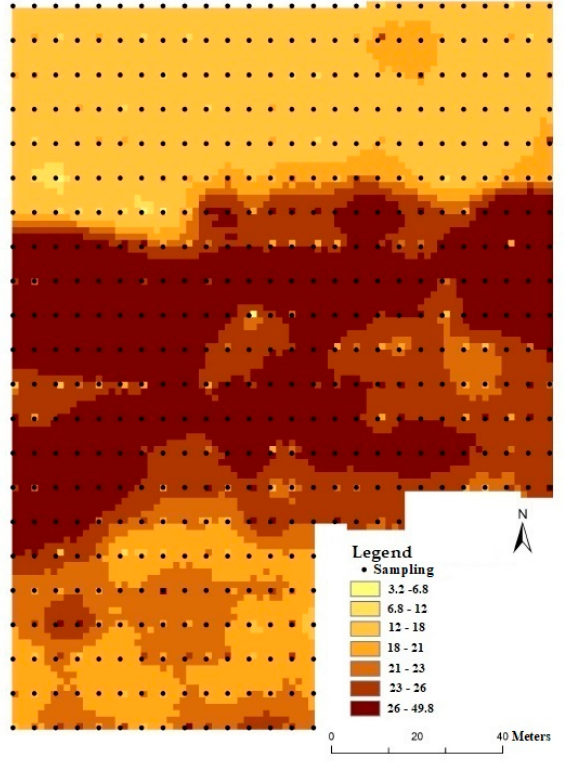
Figure 7. Grid map of VMC from 500 SGSs in the jointing stage.